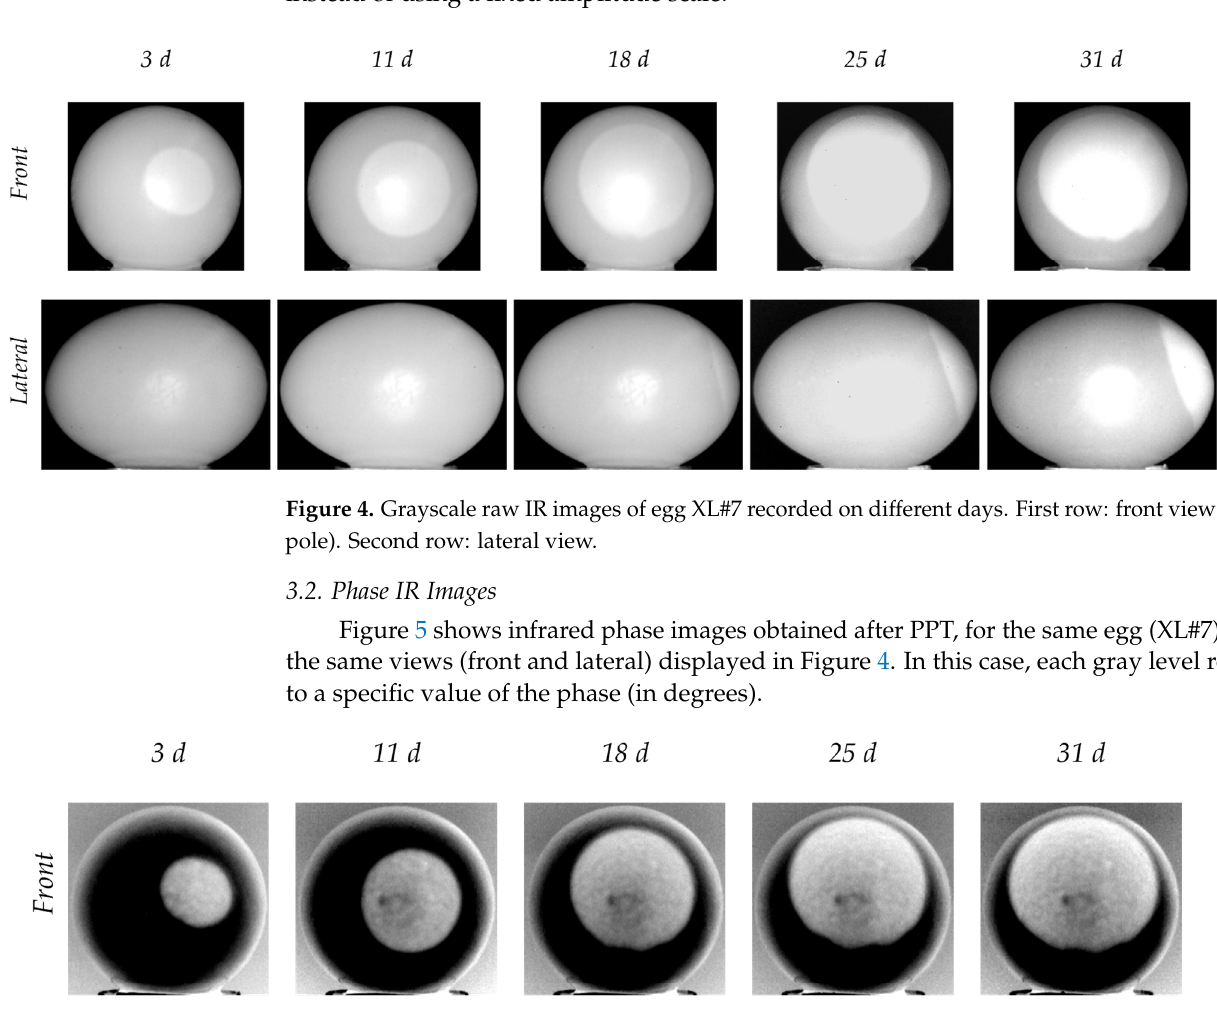
Figure 6. Block diagram of the algorithm used to estimate air chamber size from the front view using both raw and phase infrared images. Figure 7 illustrates the procedure, performed by the presented algorithm, to identify the points on the perimeter of the air chamber projection in the aforementioned, hybrid and resized image.